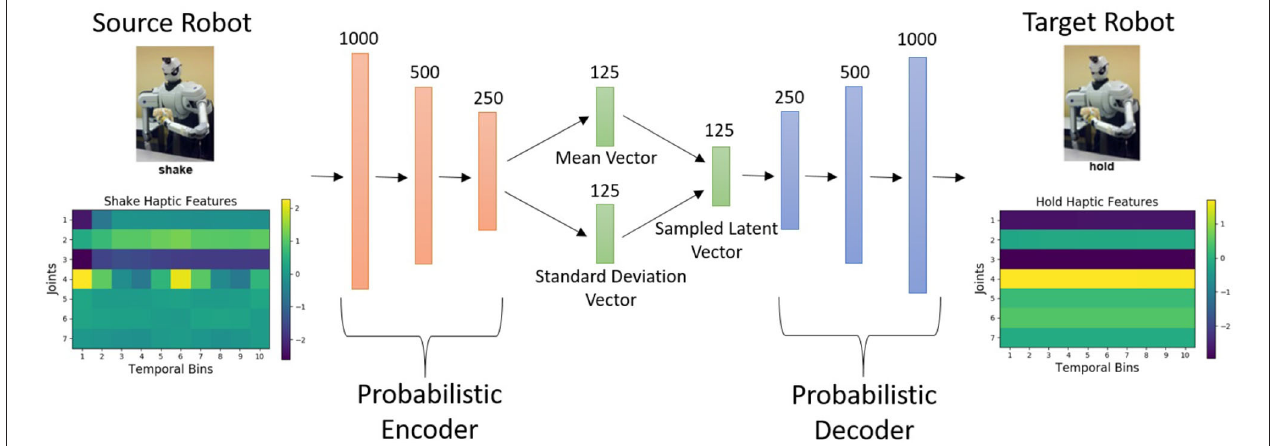
FIGURE 1 | The proposed β -VED network architecture. In this example, an input data point from the shake-haptic context is projected to the hold-haptic context. conditional, producing latent codes giving source features.